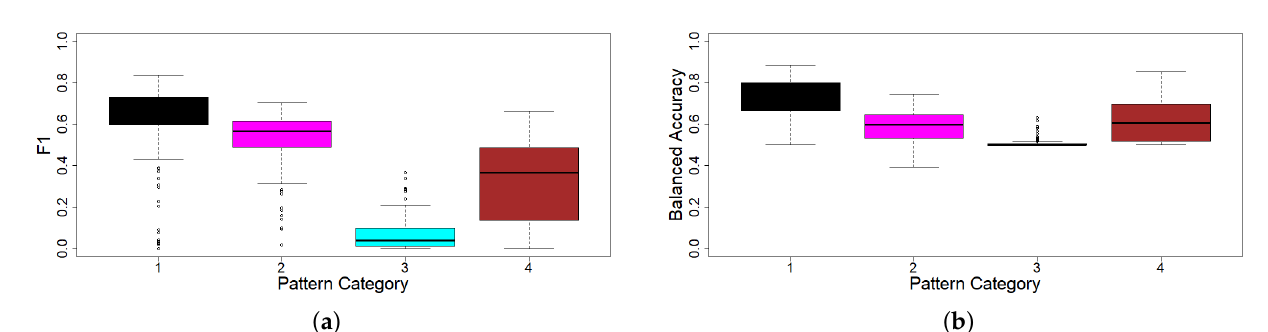
Figure 5. Statistical distributions of F1-Score ( a ) and Balanced Accuracy ( b ) performance metrics for every environmental acoustic pattern, represented as box and whisker plots.